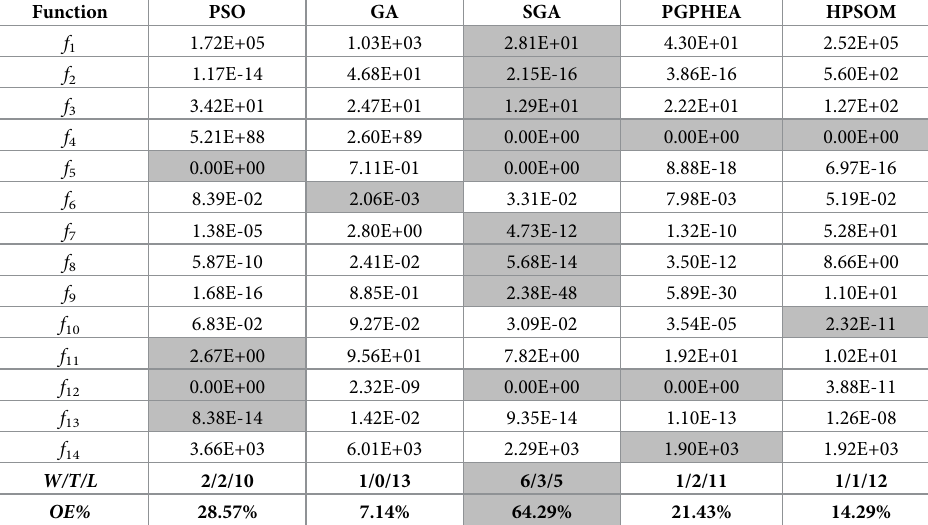
Table 3. Comparison of average error in finding the global optimum of functions f 1 - f 14 . Function